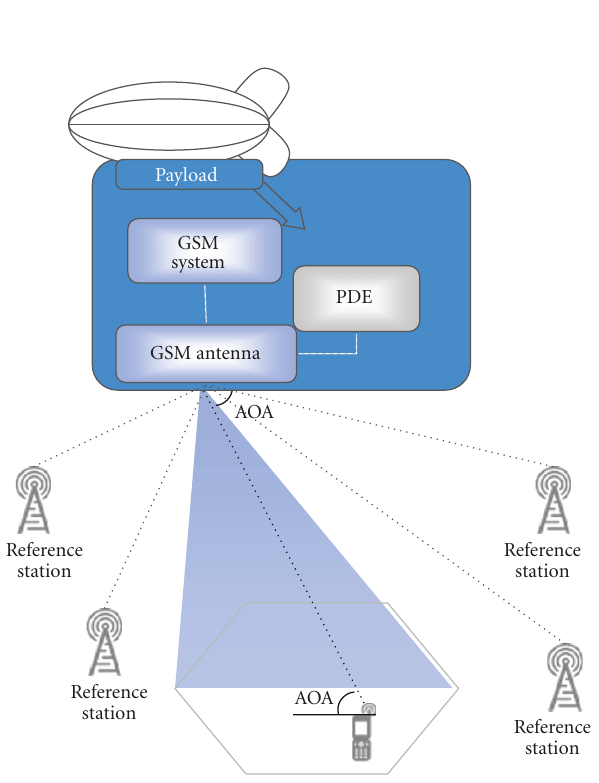
Figure 5: A-GPS using HAP.